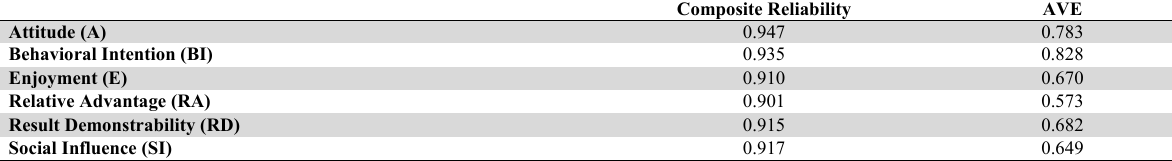
Results of Construct Reliability